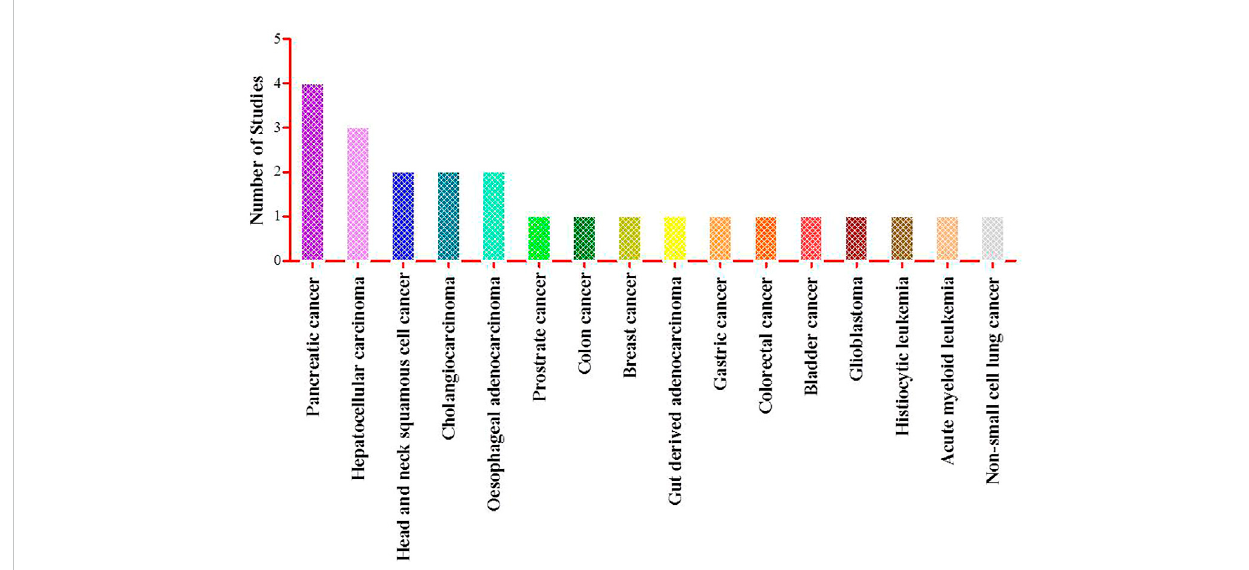
FIGURE 6 Graphical representation of different types of cancer studied in 23 selected articles.